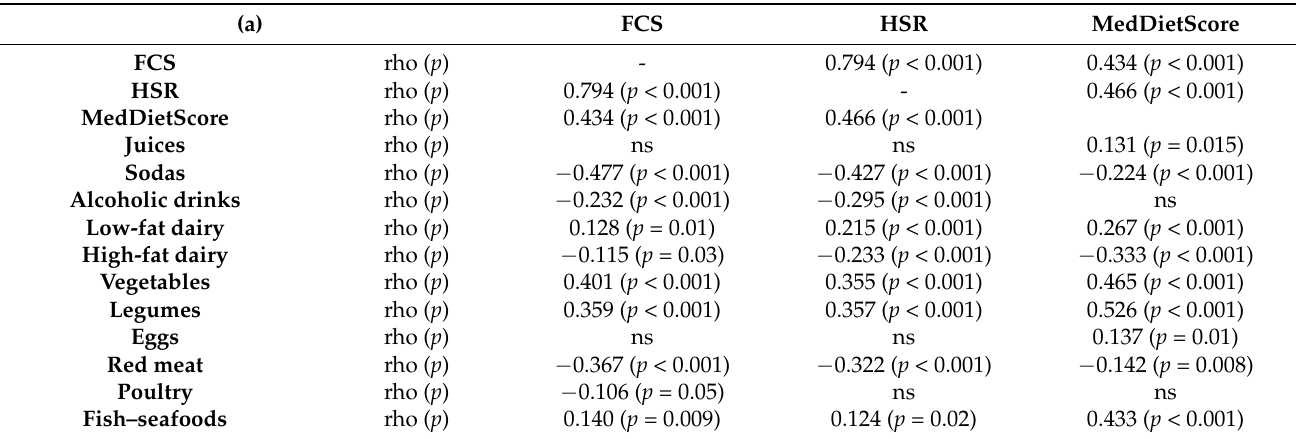
Table 3. ( a ) Spearman correlation coefficients of raw variables and ( b ) Pearson partial correlation coefficients of ranked variables adjusted for age, sex, BMI, and